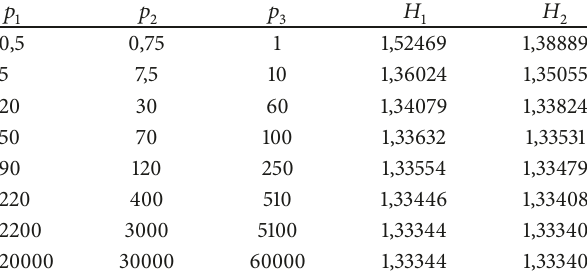
Table 4: The influence of the price on the catches.